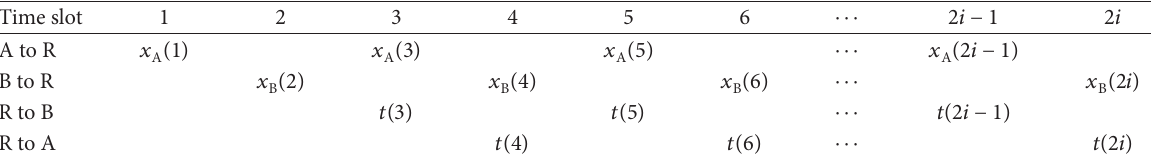
Table 1: Transmission scheme of full-duplex mode.